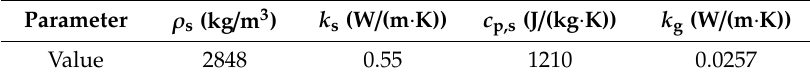
Table 2. Typical physical properties of gas and particles (Liu et al.